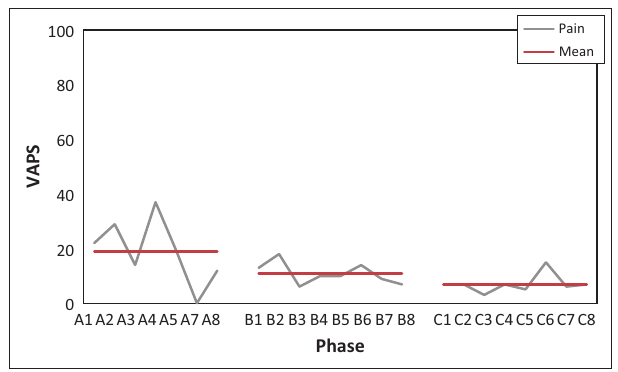
VAPS, Visual Analogue Pain Scale. FIGURE 5: Visual Analogue Pain Scale measurements with the mean for each phase.